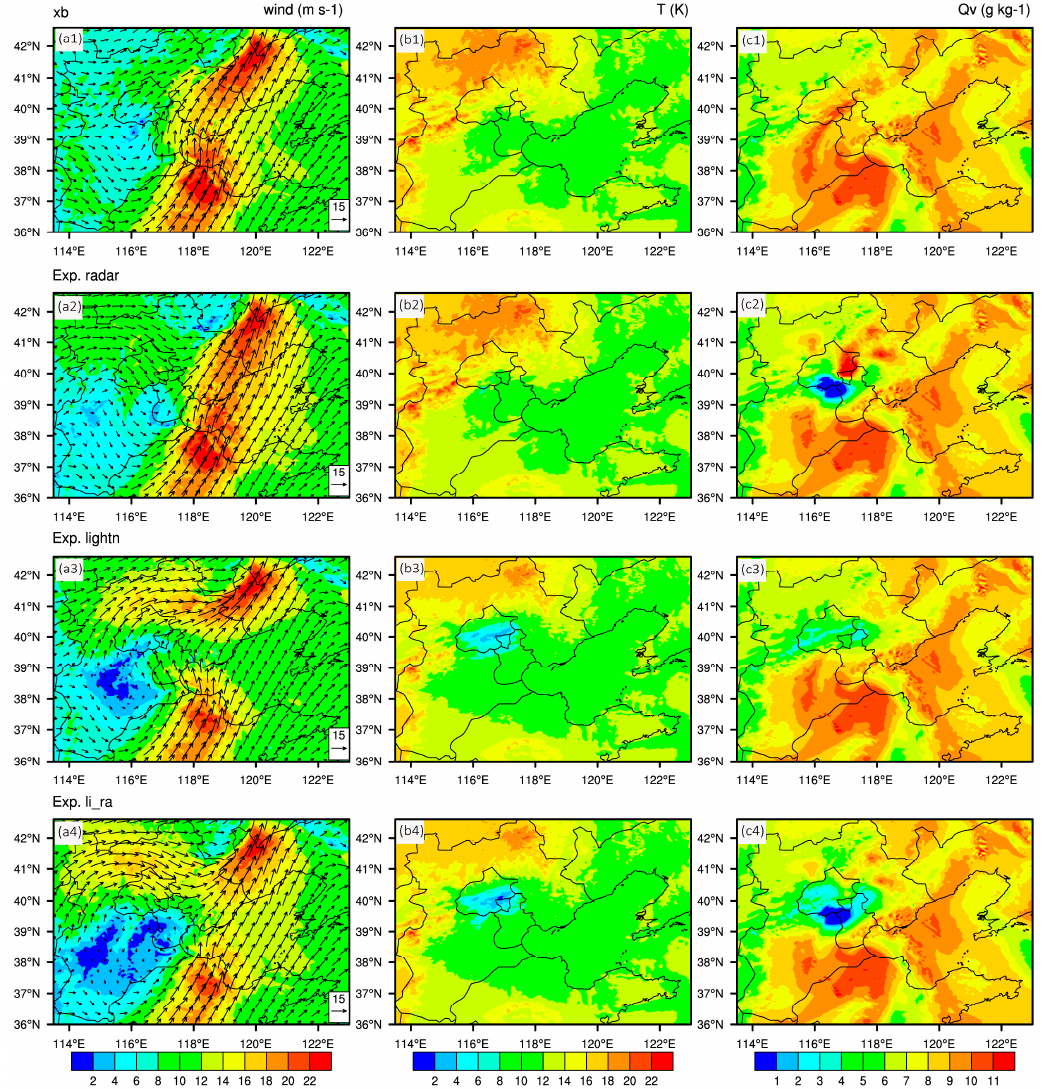
Figure 3. Background (xb) and analyzed (Exp. radar, Exp. lightn and Exp. li_ra) fields for ( a ) wind (m·s − 1 ); ( b ) perturbation potential temperature (K); and ( c ) water vapor mixing ratio (g·kg − 1 ) (at level = 14, about 4 km) at 0300 UTC.